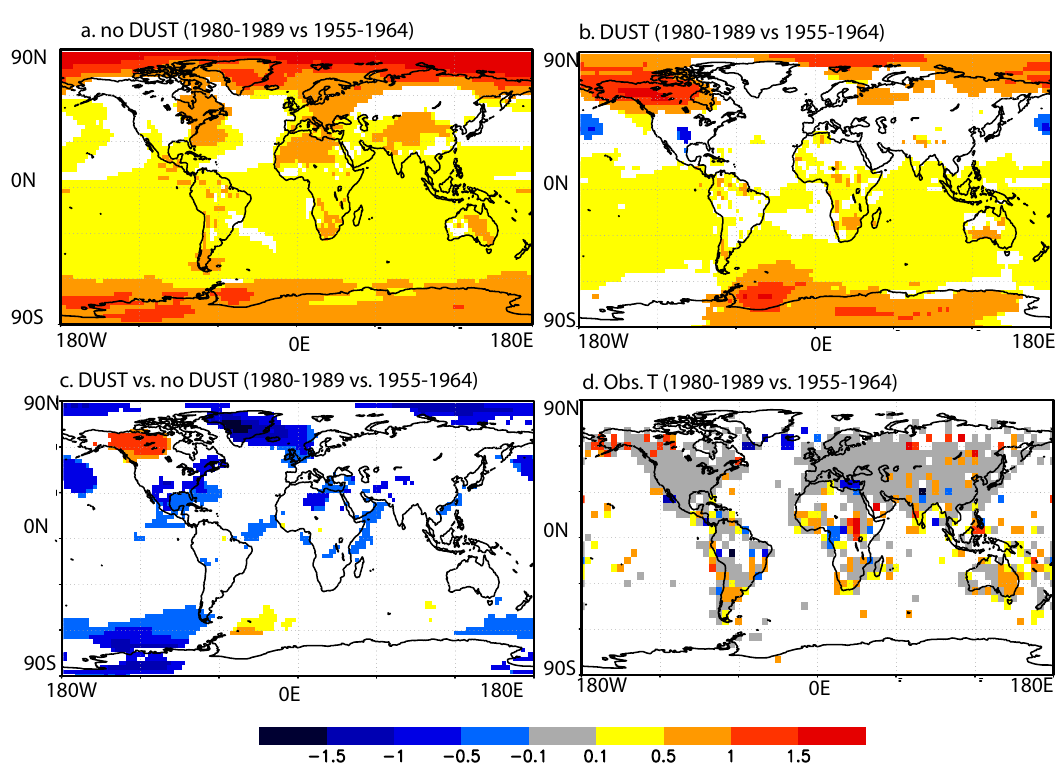
Fig. 5. Model estimated surface temperature change for 1980–1989 vs. 1955–1965 with no dust radiative forcing (a) , with dust radiative forcing (b) , and the difference in the surface temperature change (1980–1989 minus 1955–1965) between simulations with and without dust radiative forcing (c) . The change in temperature between 1980–1989 vs. 1955–1965 from observations (only over land) (d) . For (a–c) only statistically significant results at the 95% confidence level are shown, including all the ensemble members. For (d) the grey color indicates where observations are available, but did not show a statistically significant result (grey is below the statistically significant level for the modeled